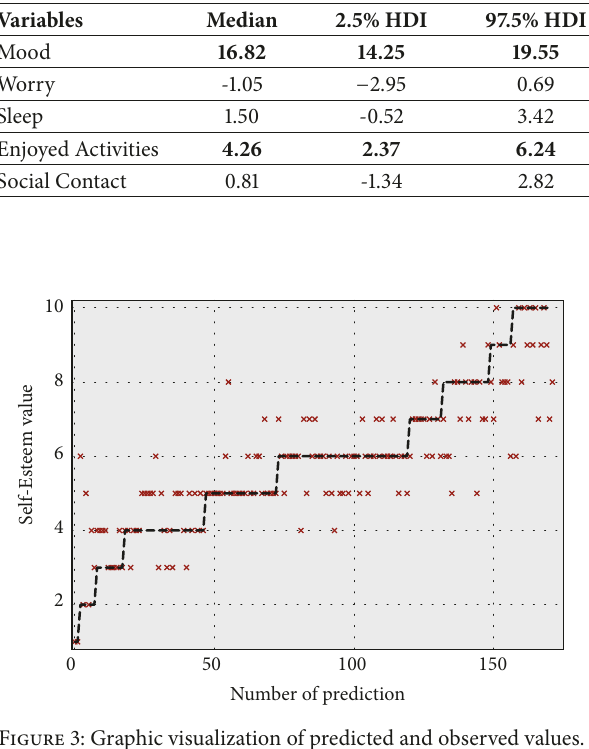
once, the prediction was four categories off; however, it was frequently falsely predicted with a distance of two